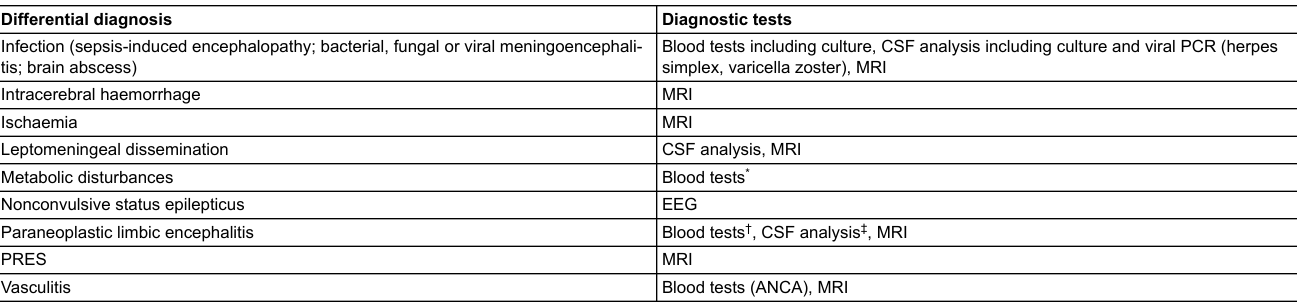
Table 4: Differential diagnosis of ICI-associated encephalitis. Differential diagnosis